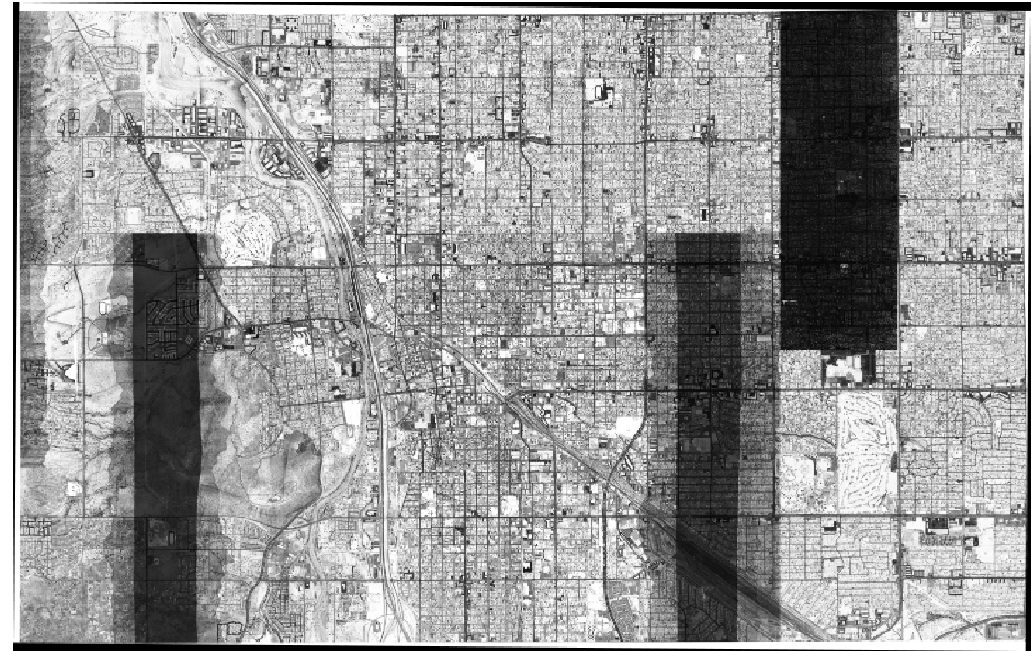
Figure 6. Flight line calibration and gain changes cause large variability in the 2008 LiDAR return intensity data in the selected study area, making it difficult in this case to include these to improve the